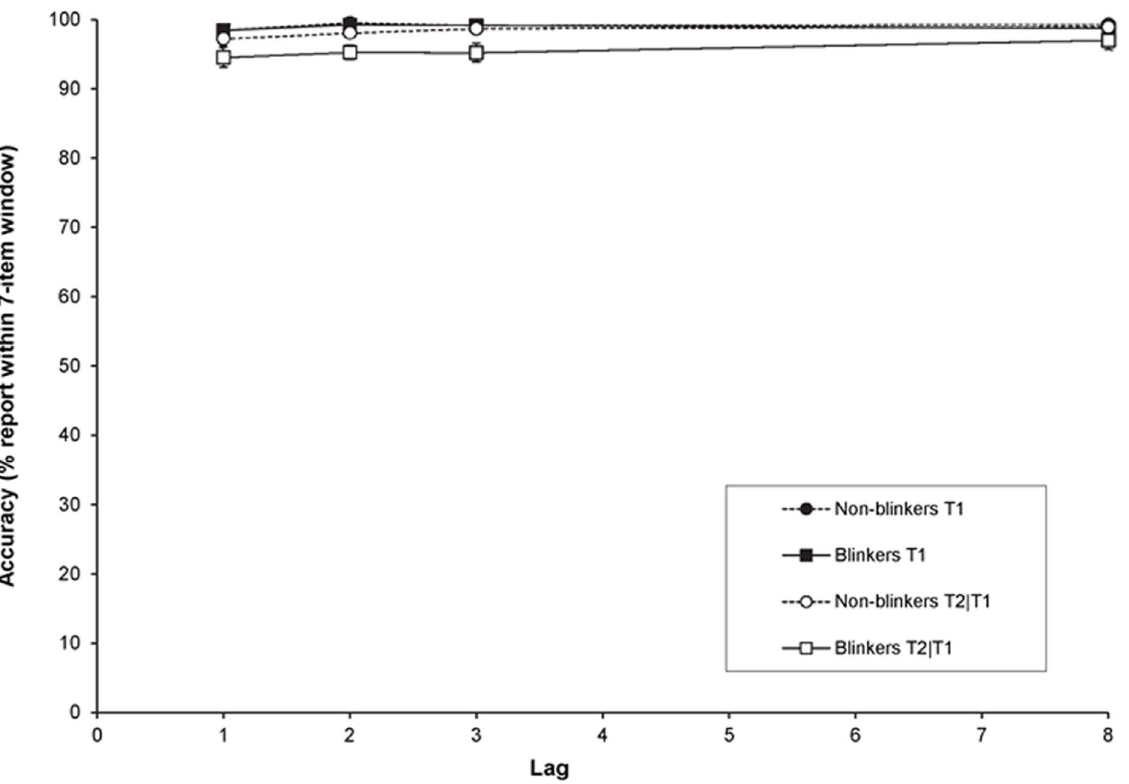
Figure 3. Suppression in Experiment 1b. Suppression of the temporal selection process expressed as the accuracy of reporting an item within the 7-item window around a given target as a function of lag, for blinkers and